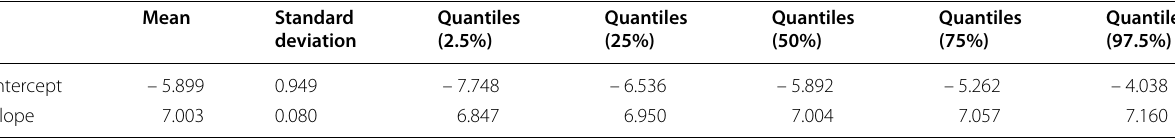
Table 2 Bayesian results for Antarctic snow (Case 1) Mean Standard